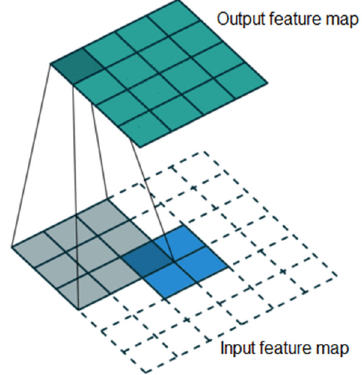
Figure 3. Schematic diagram of deconvolution.